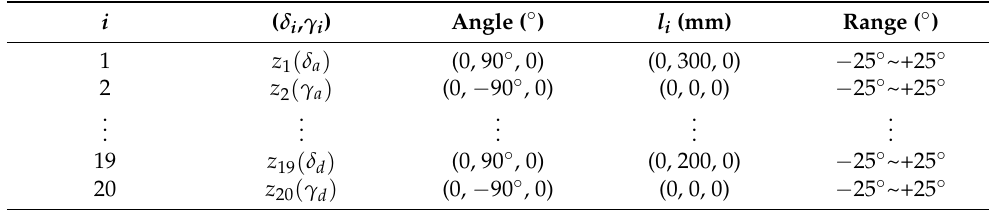
Table 2. SAM coordinate transformation D − H